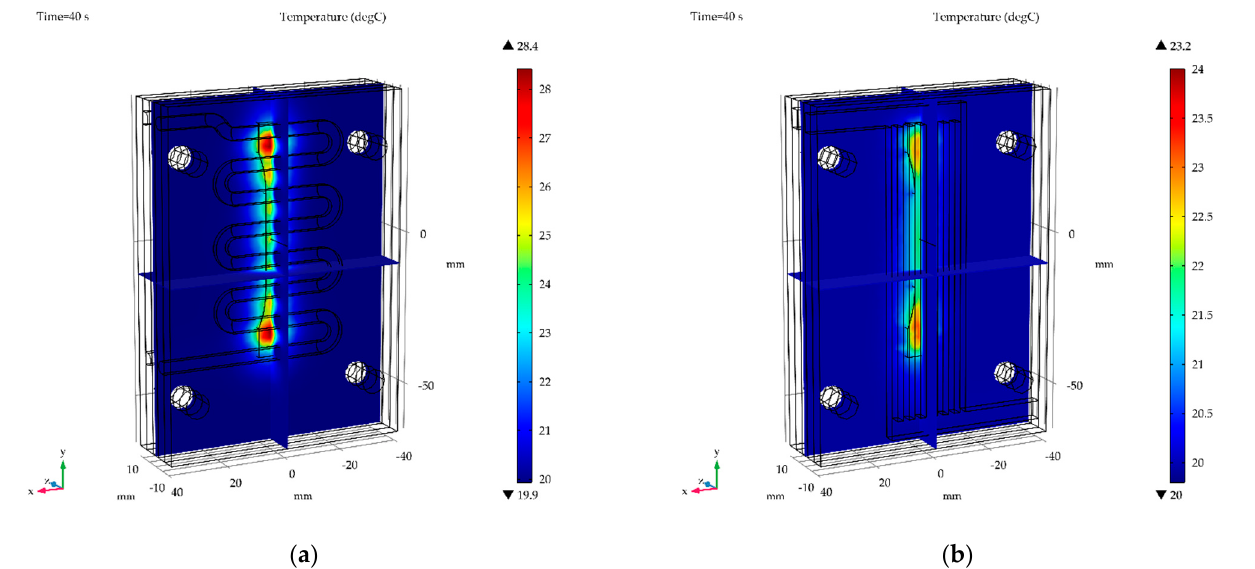
Figure 24. The temperature distribution in wax injection mold for the water cooling variant with: ( a ) rounded channels, ( b ) finned channels.